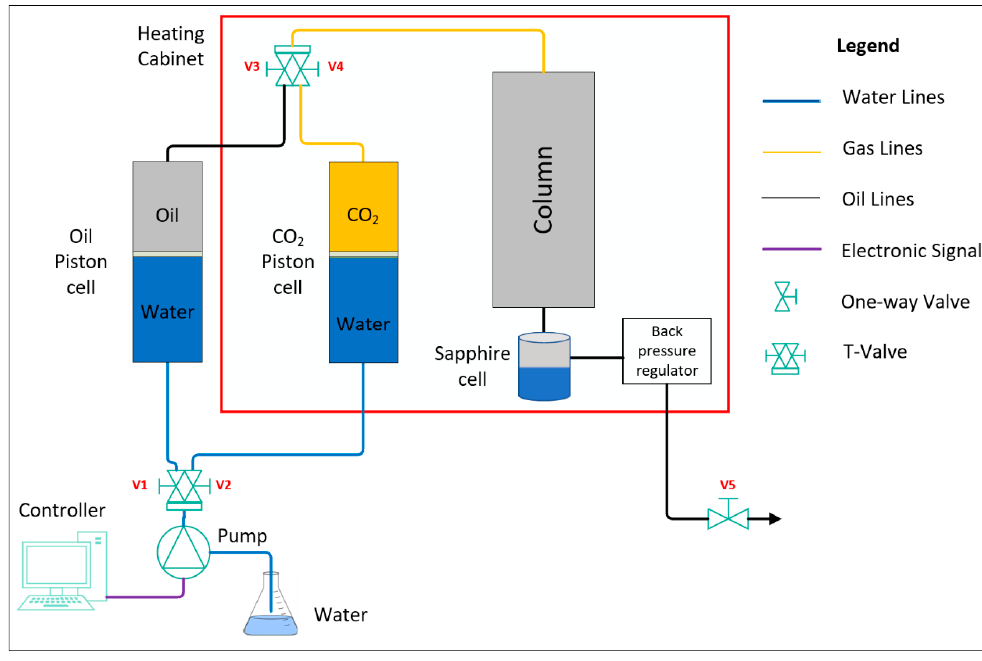
Figure 5. Piping and instrumentation (P and ID) diagram of the experimental setup.